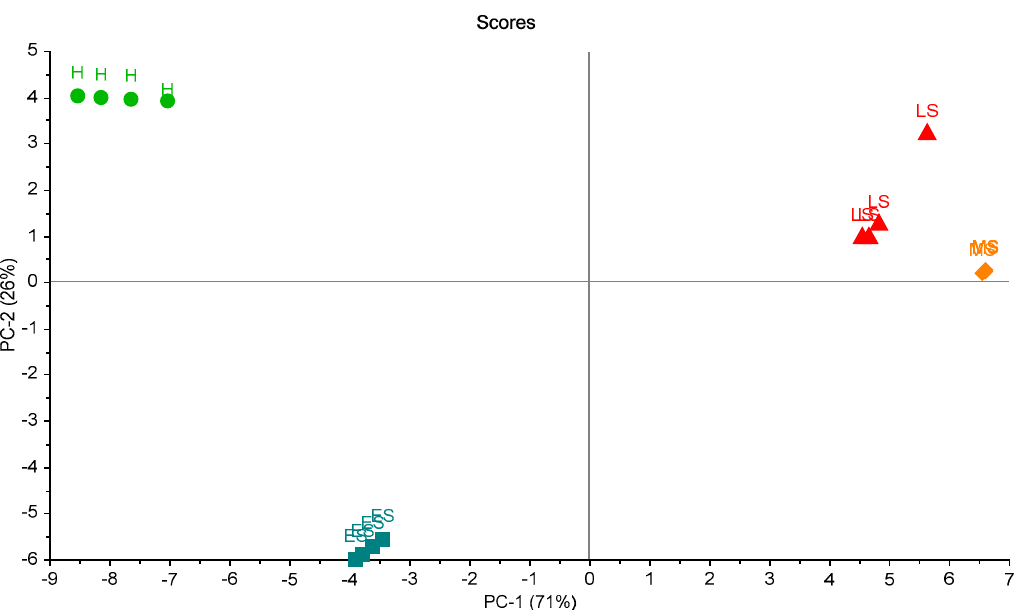
Figure 8. Scores plot of the samples in the second trial of measurements. A clear separation between samples is shown. Healthy sample (H), infected early-stage (ES), infected moderate-stage (MS), and infected late-stage (LS).